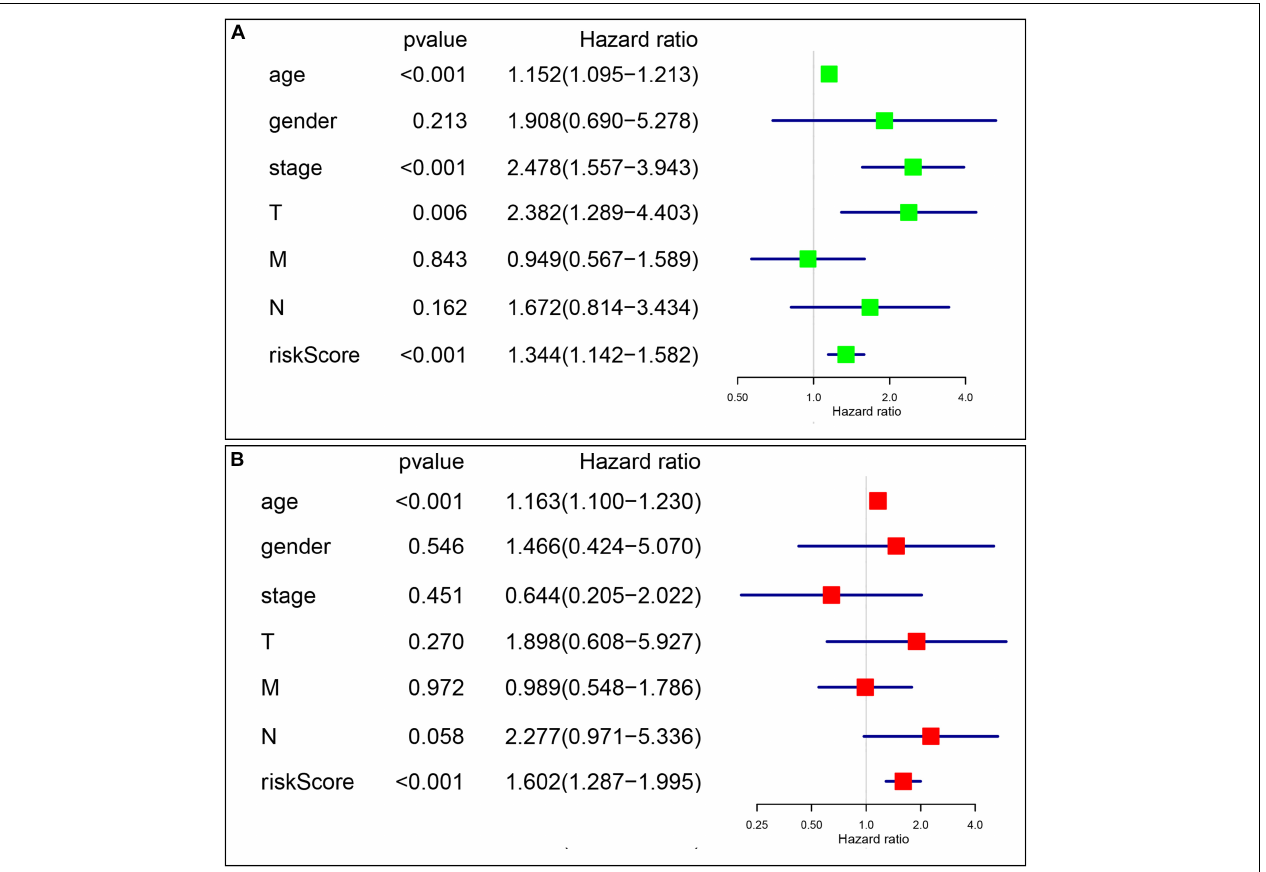
FIGURE 7 | The signature-based risk score was an independent prognostic factor. (A) Univariate analysis of the risk score and clinicopathological features in TCGA thyroid cancer cohort. (B) Multivariate analysis of the risk score and clinicopathological features in TCGA thyroid cancer